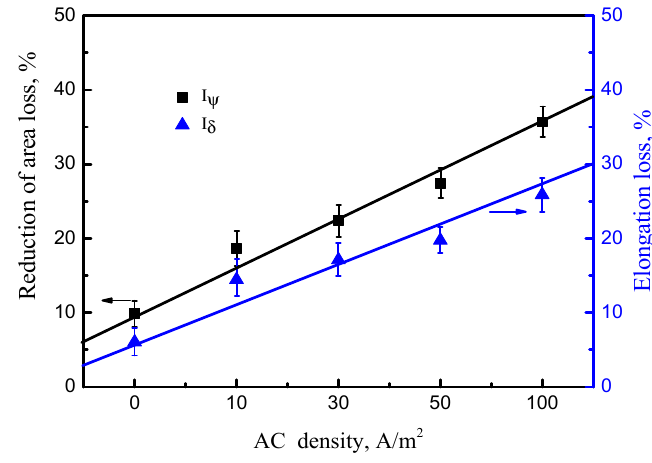
Figure 9. SCC susceptibility of the X70 steel at various AC densities in simulated seawater.